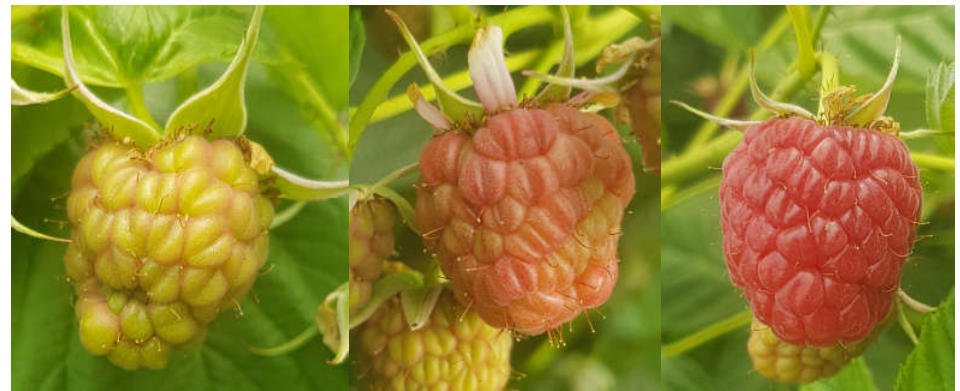
Figure 1. The three stages (green, ripening and ripe fruit) of raspberry fruit development inoculated in 2020 to investigate skin lesion development and stigmata infections by Cladosporium .